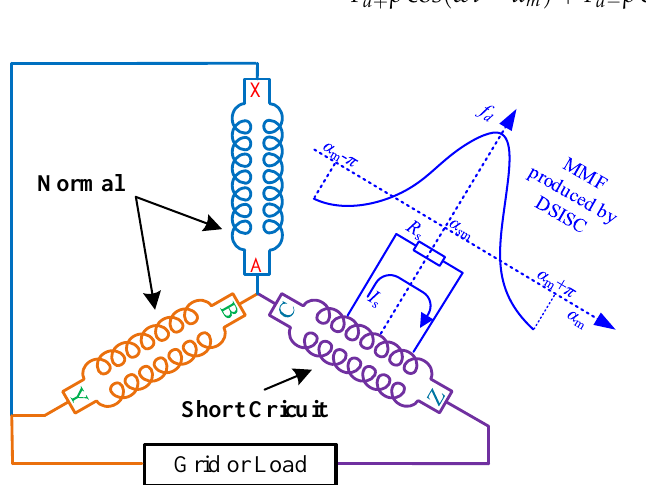
Figure 3. The MMF vector diagram: ( a ) Normal, ( b ) DSISC.